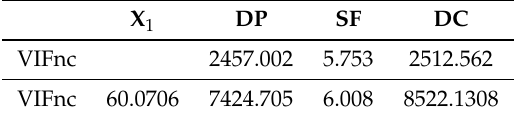
Table 13. VIFnc of auxiliary regressions associated to Model